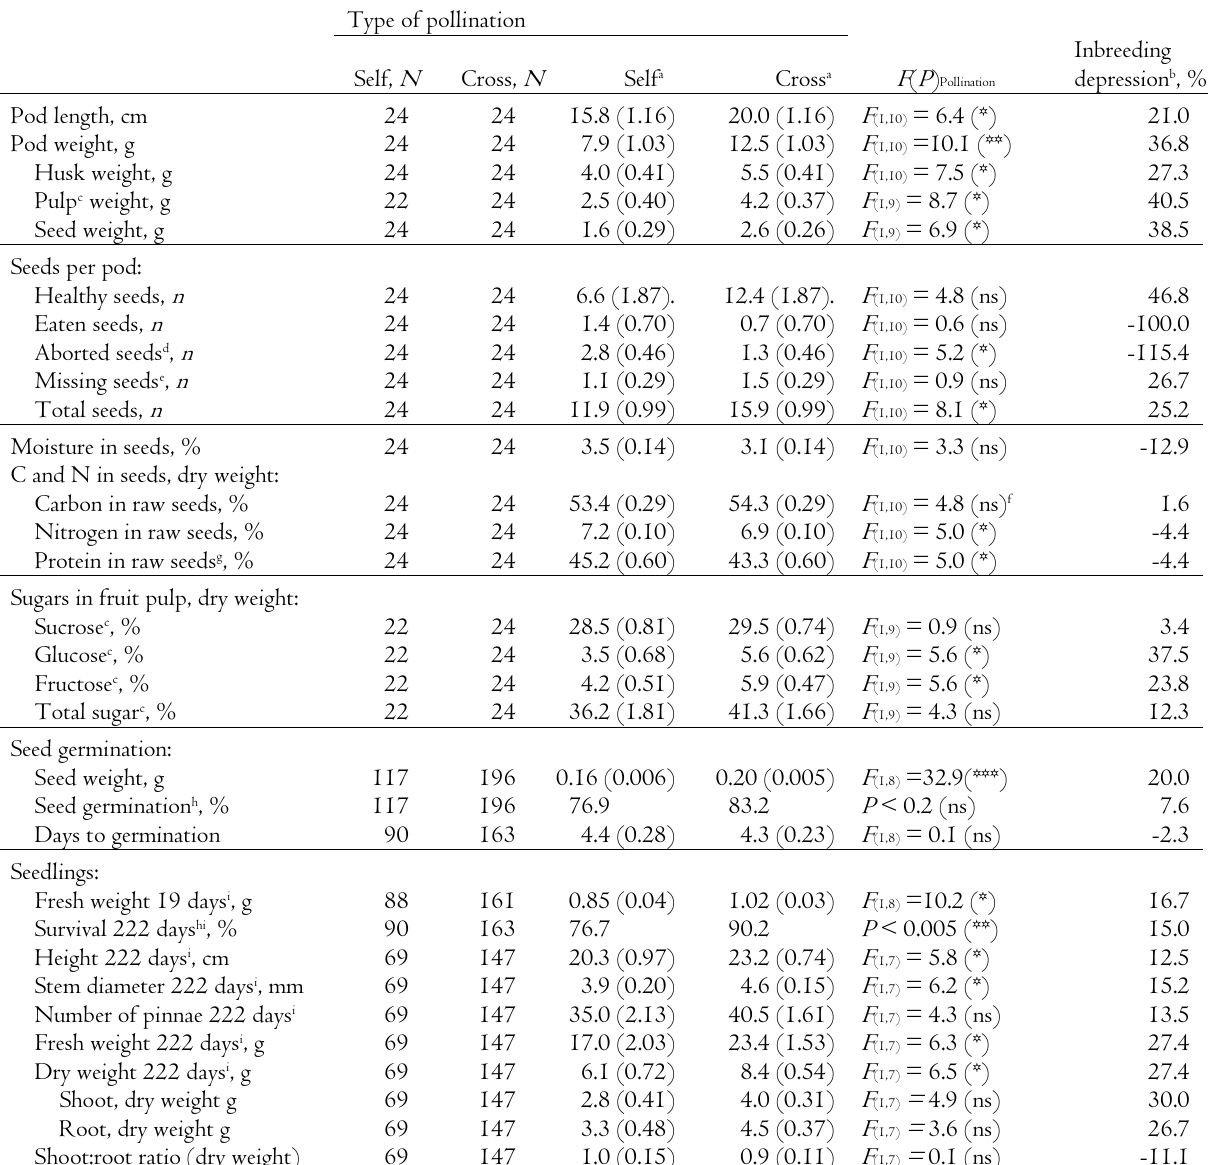
Influence of self- versus cross-pollination on the fitness of various parameters of pods and seeds of Parkia biglobosa including F- tests, Fisher’s exact tests, and their significance